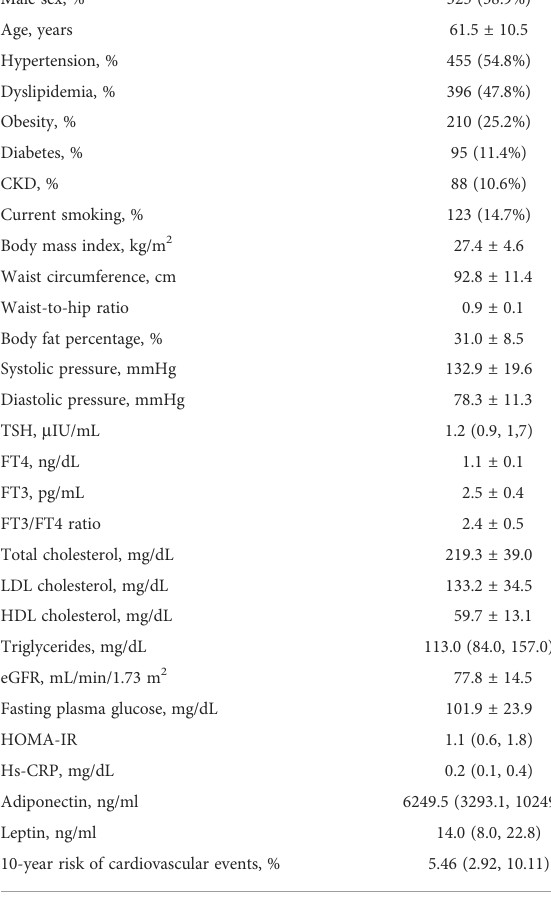
TABLE 1 Characteristics of the study sample